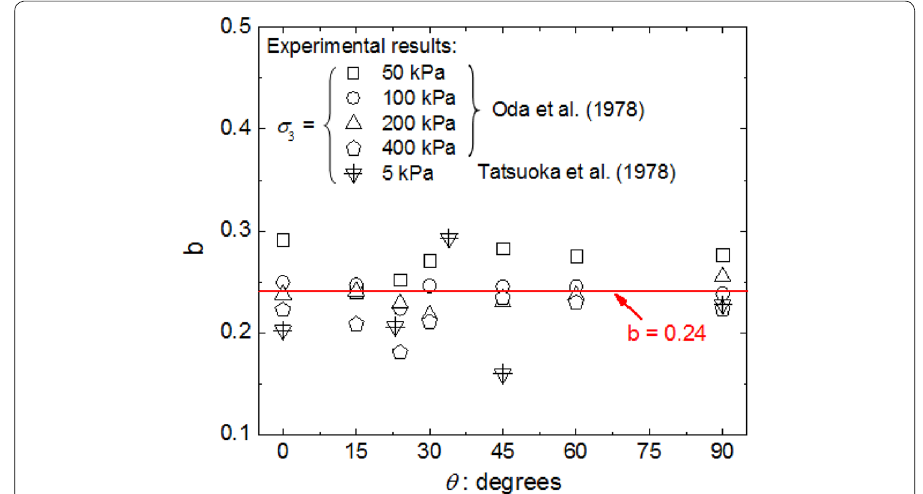
Fig. 15 The b at failure in plane strain compression